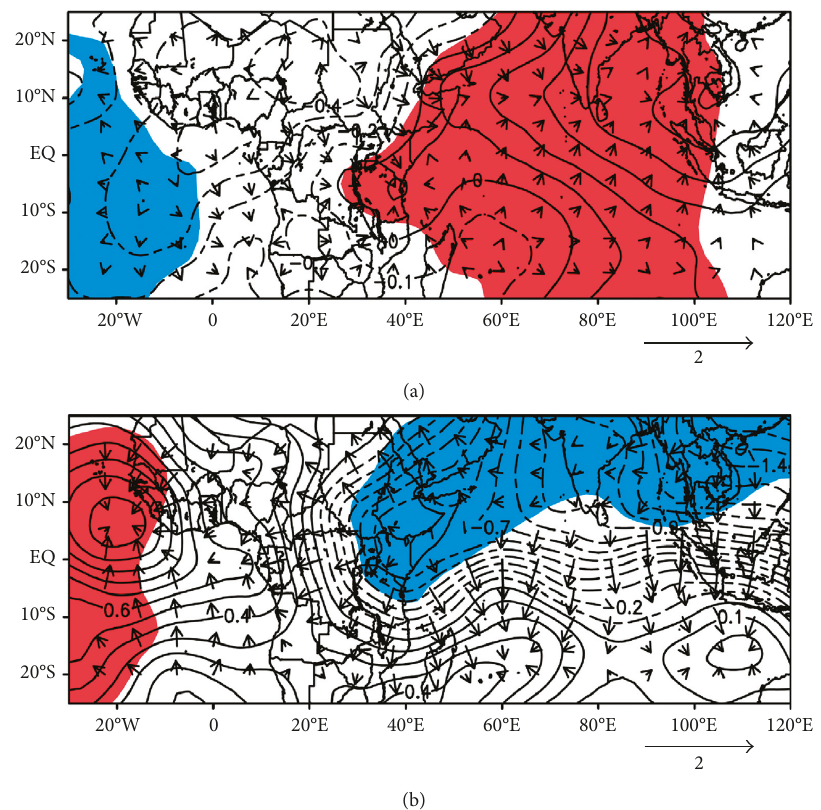
Figure 8: Composite velocity potential and wind divergent anomalies at (a) 850hPa and (b) 200hPa for stations over the northern coast and NEH during anomalous heavy rainfall; units for velocity potential being 1 significant areas at 95% confidence